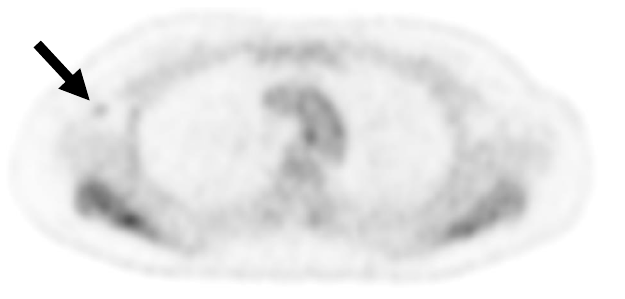
Table 6. Diagnostic accuracy of ALN metastasis *.